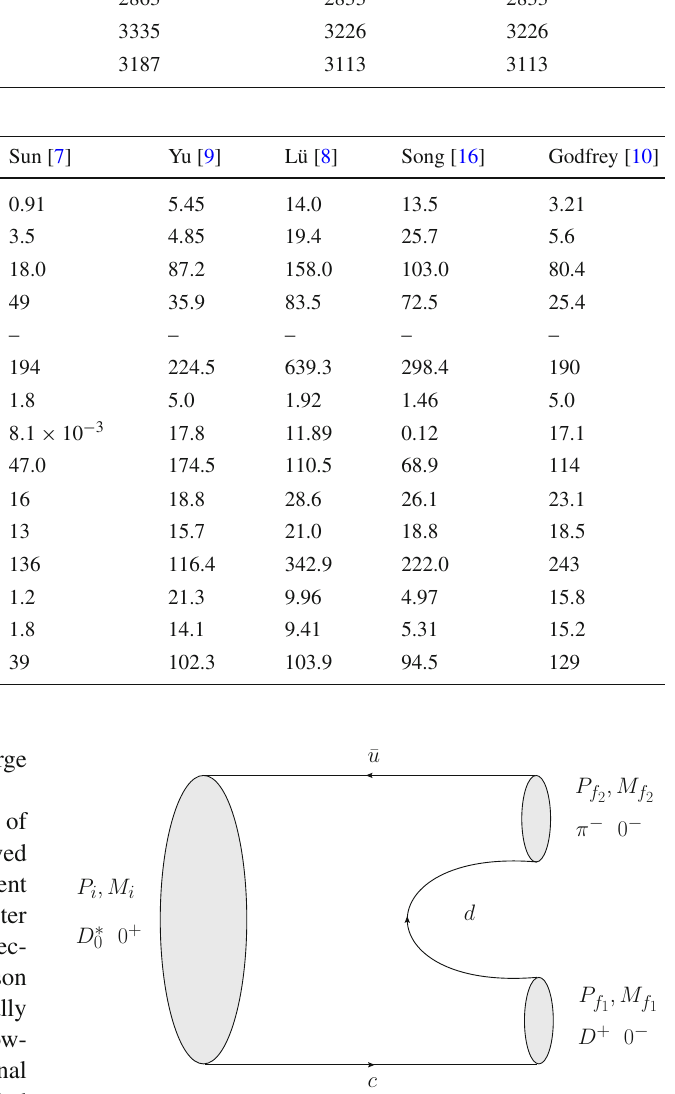
2 Two-body strong decay ( 2400 ) 0 → D + π − as an example We take the channel D ∗ 0 to illustrate the calculation details. The Feynman diagram of this process is shown in Fig.